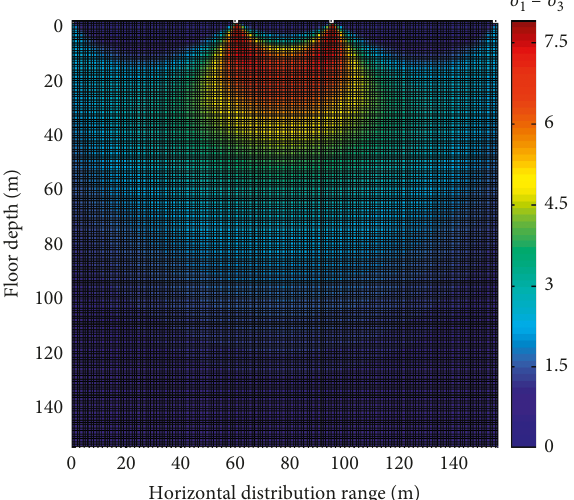
Figure 4: Distribution of principal stress difference in bedrock.